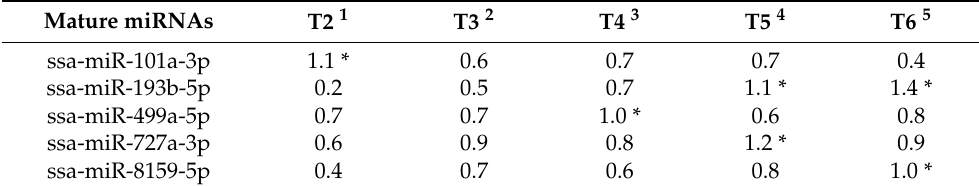
Table 2. Expression changes of gDE miRNAs in cluster 2. Mature